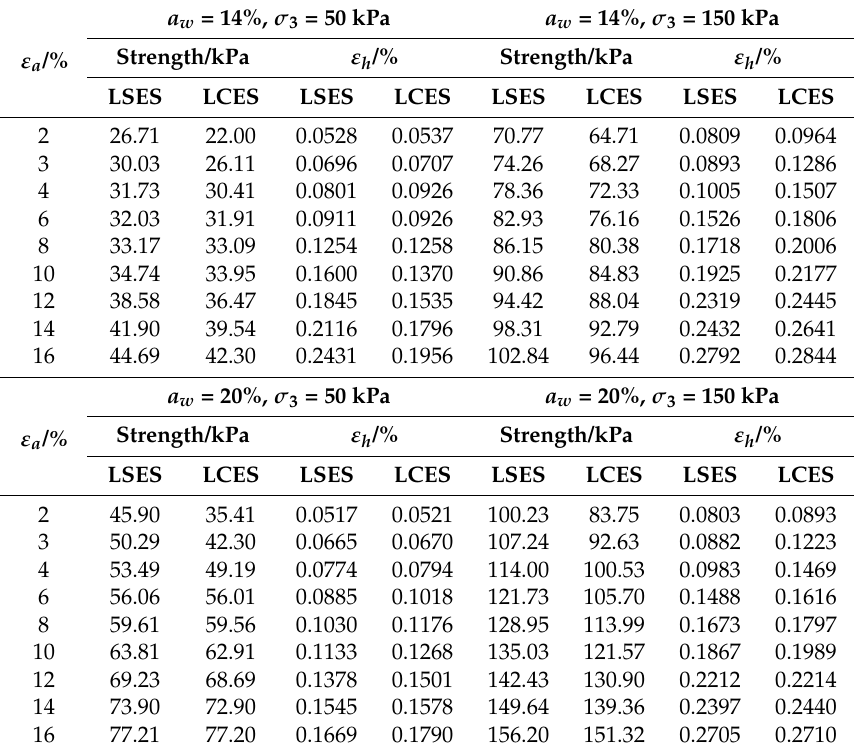
Table 3. Strength and elastic strain corresponding to the resilient modulus in Figure